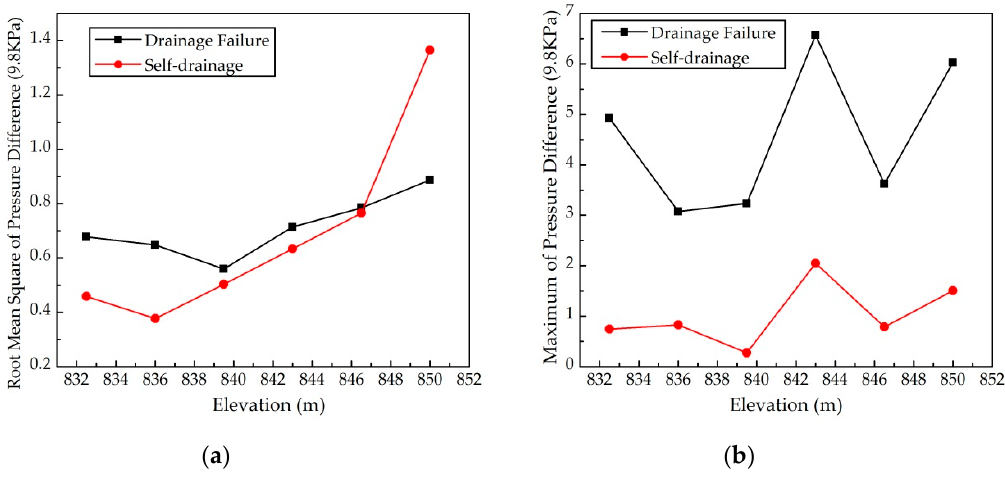
Figure 18. RMS and maximum values of the difference between the fluctuating pressure histories measured at test point pairs with different elevations for drainage failure and self-drainage plates. ( a ) RMS values; and ( b ) maximum values.